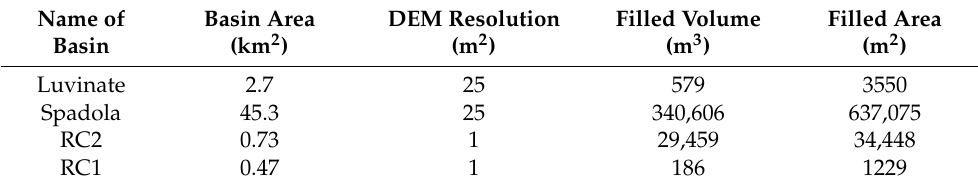
Table 1. Available data and results of the depression filling algorithm (Wang and Liu,